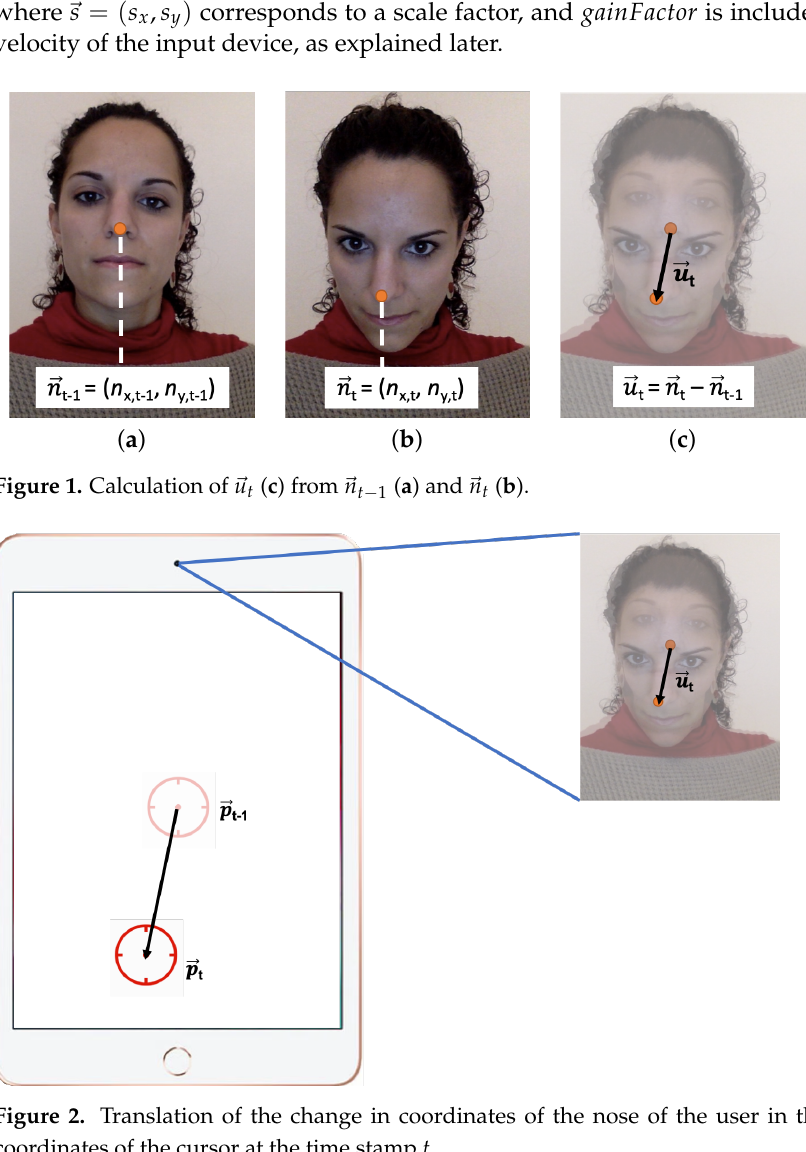
Figure 2. Translation of the change in coordinates of the nose of the user in the change in the coordinates of the cursor at the time stamp t